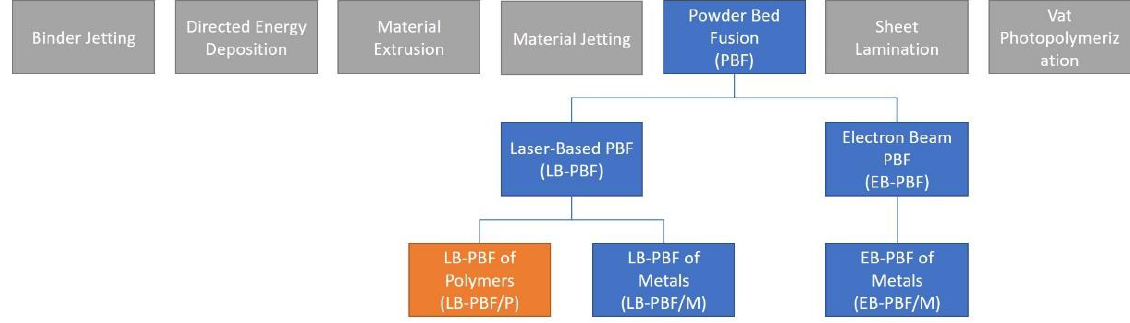
Figure 1. Process categories in additive manufacturing as defined in ISO/ASTM 52900:2015 and 52911:2019.